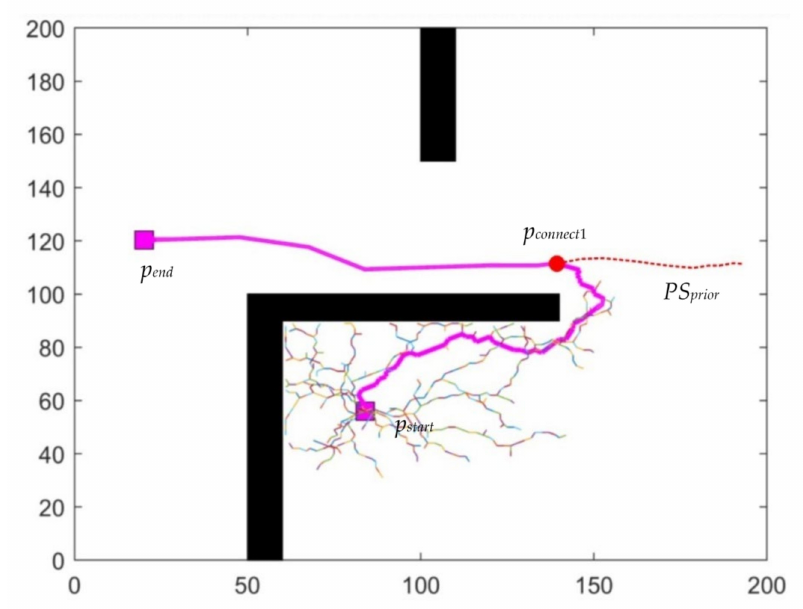
Figure 5. A path planned using S-RRT* for static reuse of a priori